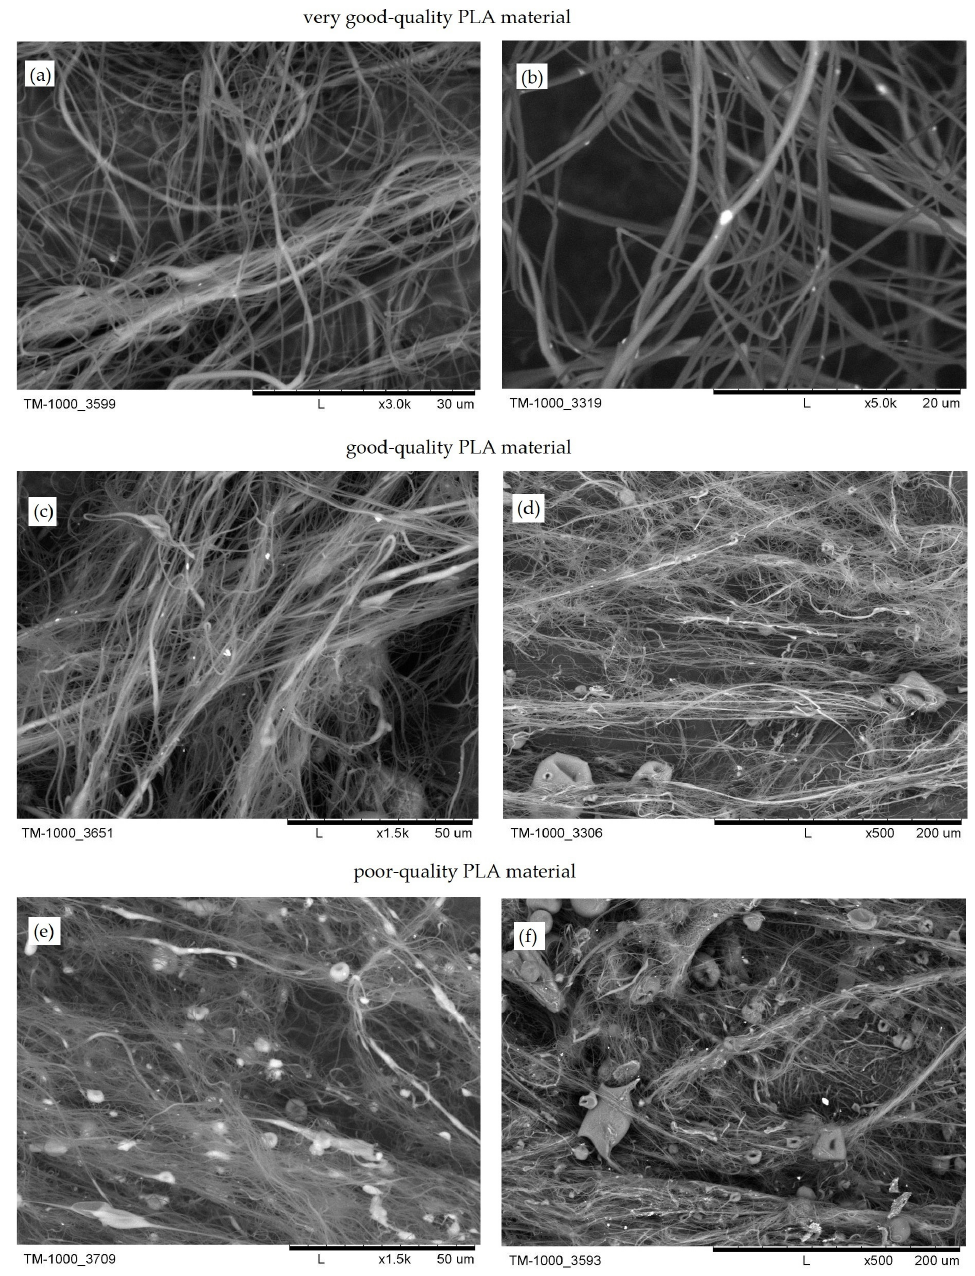
Figure 3. Exemplary very ‐ good ‐ quality materials: ( a ) 4% PLA, 0.2 mL/min, 0.5×10 5 Pa; ( b ) 6% PLA, 0.4 mL/min, 1×10 5 Pa; good ‐ quality materials: ( c ) 4% PLA, 0.2 mL/min, 1×10 5 Pa; ( d ) 6% PLA, 0.2 mL/min, 1×10 5 Pa; poor ‐ quality materials: ( e ) 4% PLA, 0.5 mL/min, 1×10 5 Pa; ( f ) 6% PLA, 0.5 mL/min, 0.5×10 5 Pa .